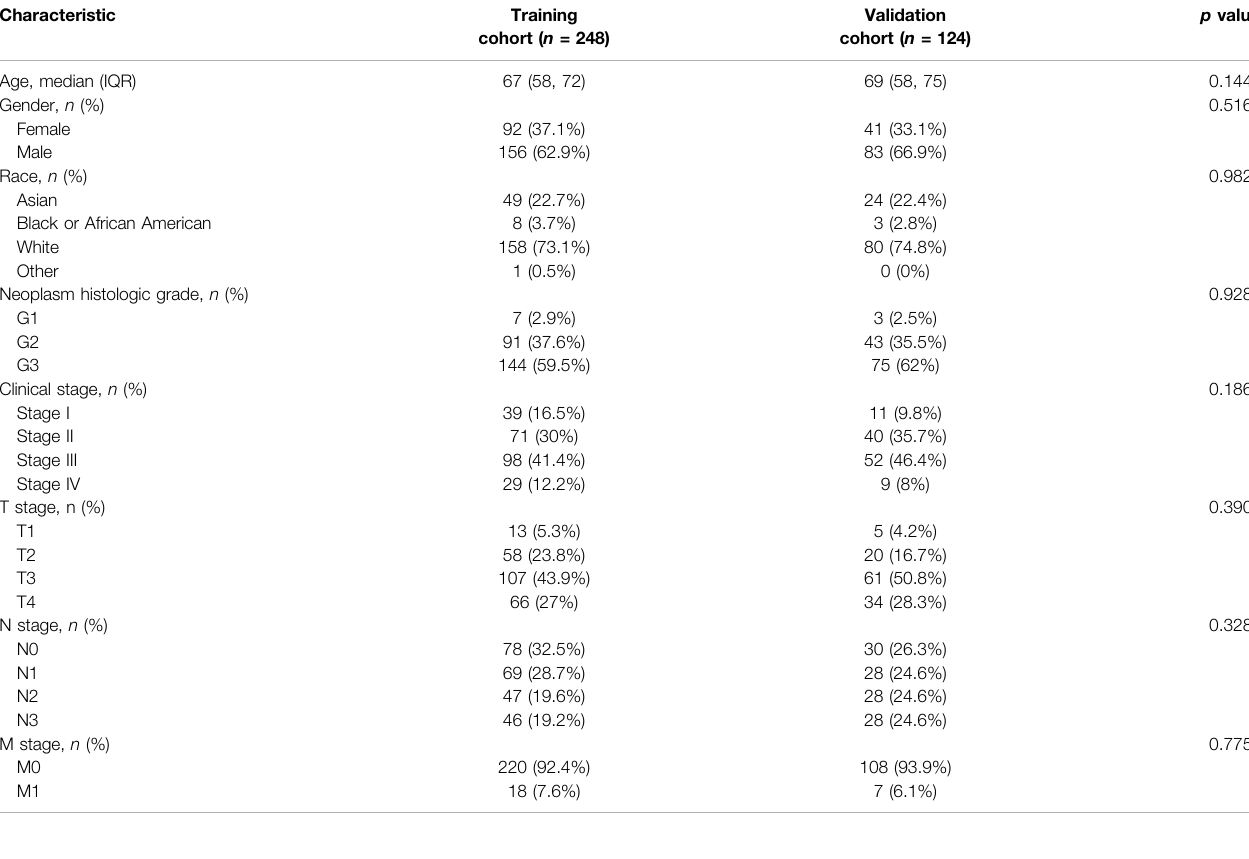
TABLE 1 | The characteristics of gastric cancer patients in training cohort and validation cohort. Characteristic